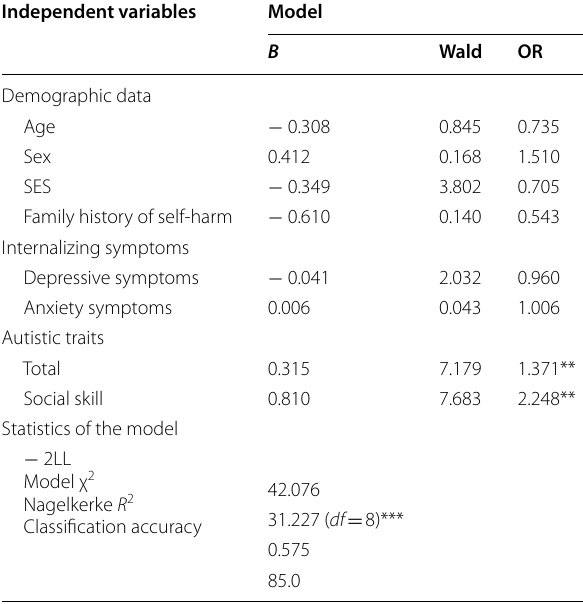
Table 2 Binary logistic regression analyses with self-harm, recurrence of self-harm as a dependent variable